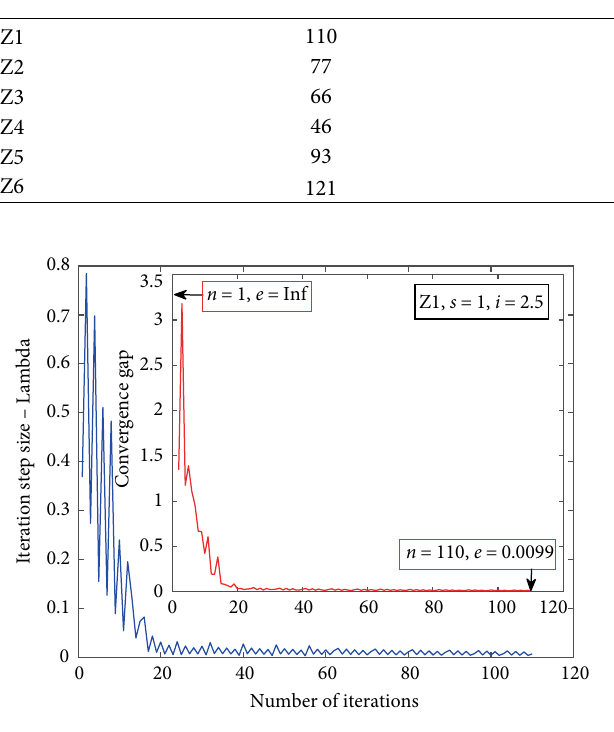
Figure 2: Curve of convergence gap of SDA in this example.